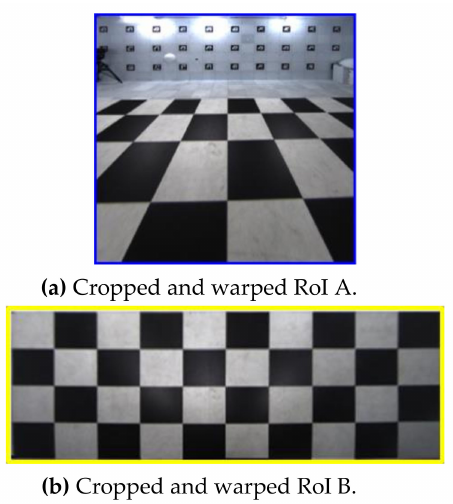
Figure 6. Cropped and warped images of RoIs A and B in Figure 5.